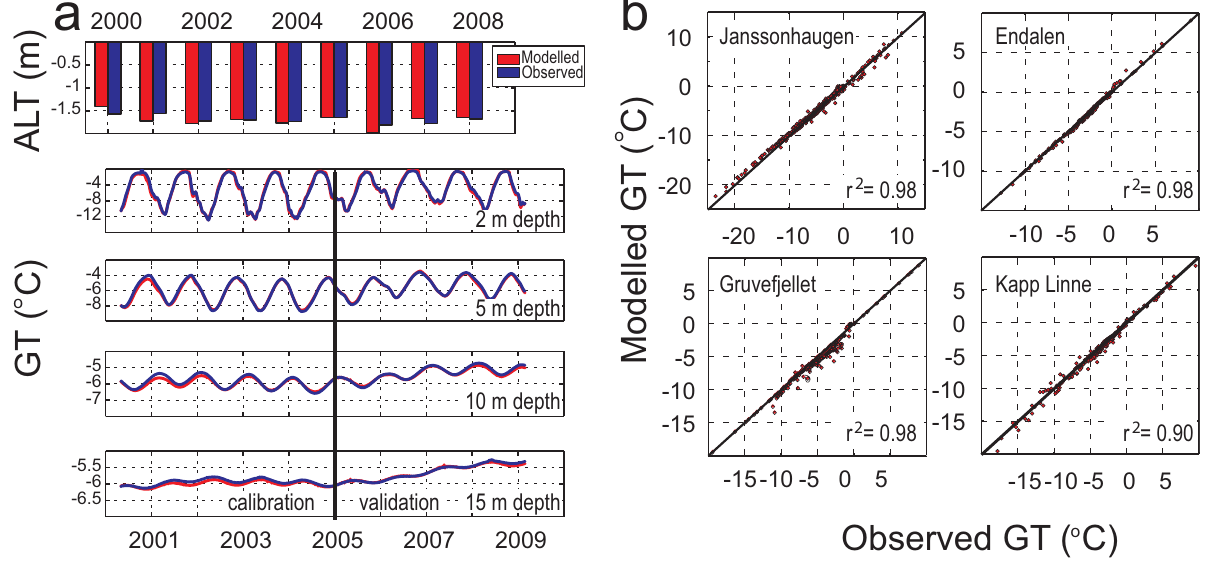
Fig. 4. (a) Calibration and validation plots for Janssonhaugen, comparing active layer thickness (ALT, upper) and temperature development in different depths (lower, note different scaling of GT axes). (b) Scatter plots of measured vs. modelled ground temperatures at the various study